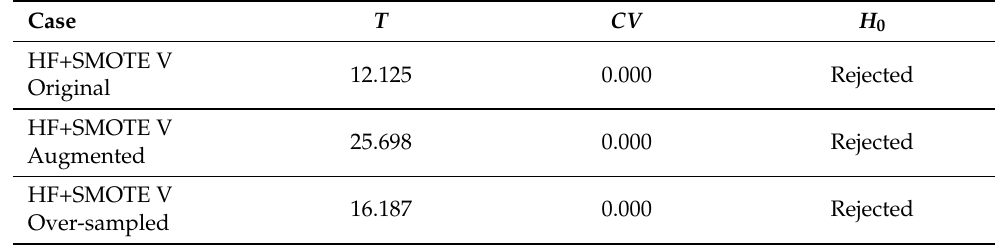
Table 16. Statistically significant